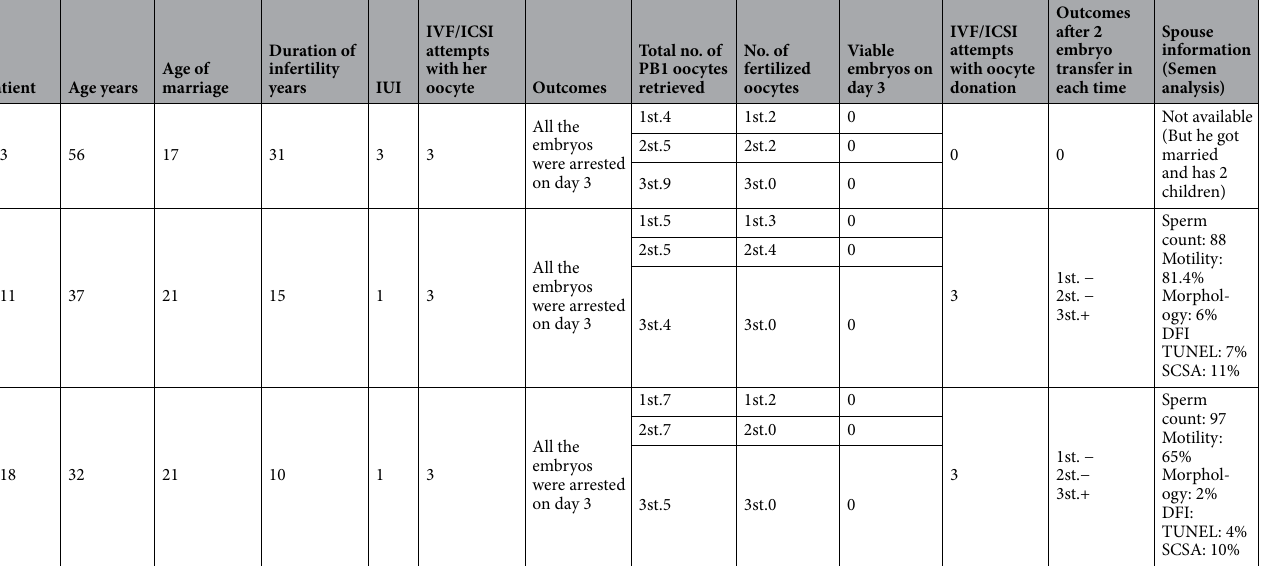
Table 1. Oocyte and embryo characteristics of the IVF and ICSI attempts of the female